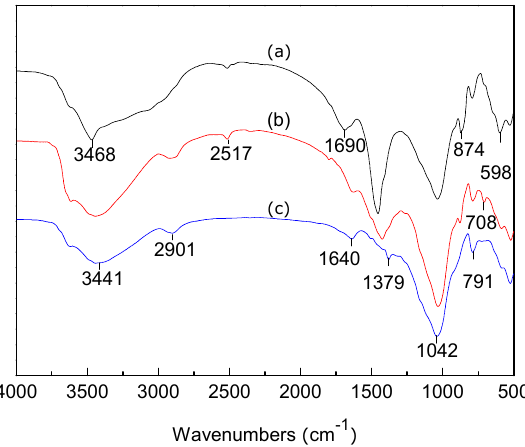
Figure 17. Fourier Transform Infrared Spectroscopy (FTIR) spectra of ( a ) LMT, ( b ) Co(II) ‐ loaded LMT, and ( c ) recovered LMT.